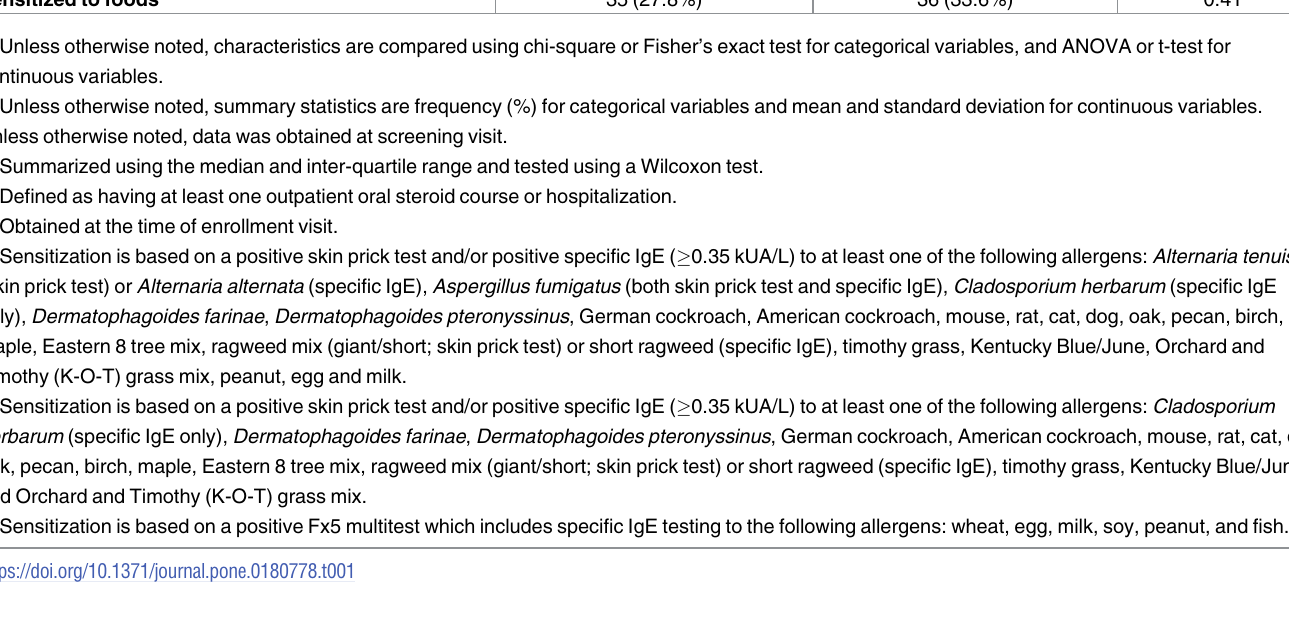
Table 2. Concentrations of blood eosinophils and neutrophils by treatment classification1.